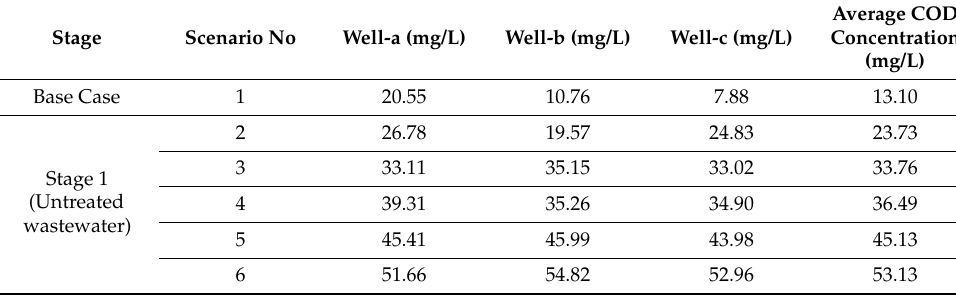
Figure 8. Distribution of COD in the ENDA for different scenarios (2 − 6) of stage 1. Table 4. COD concentration for different scenario .